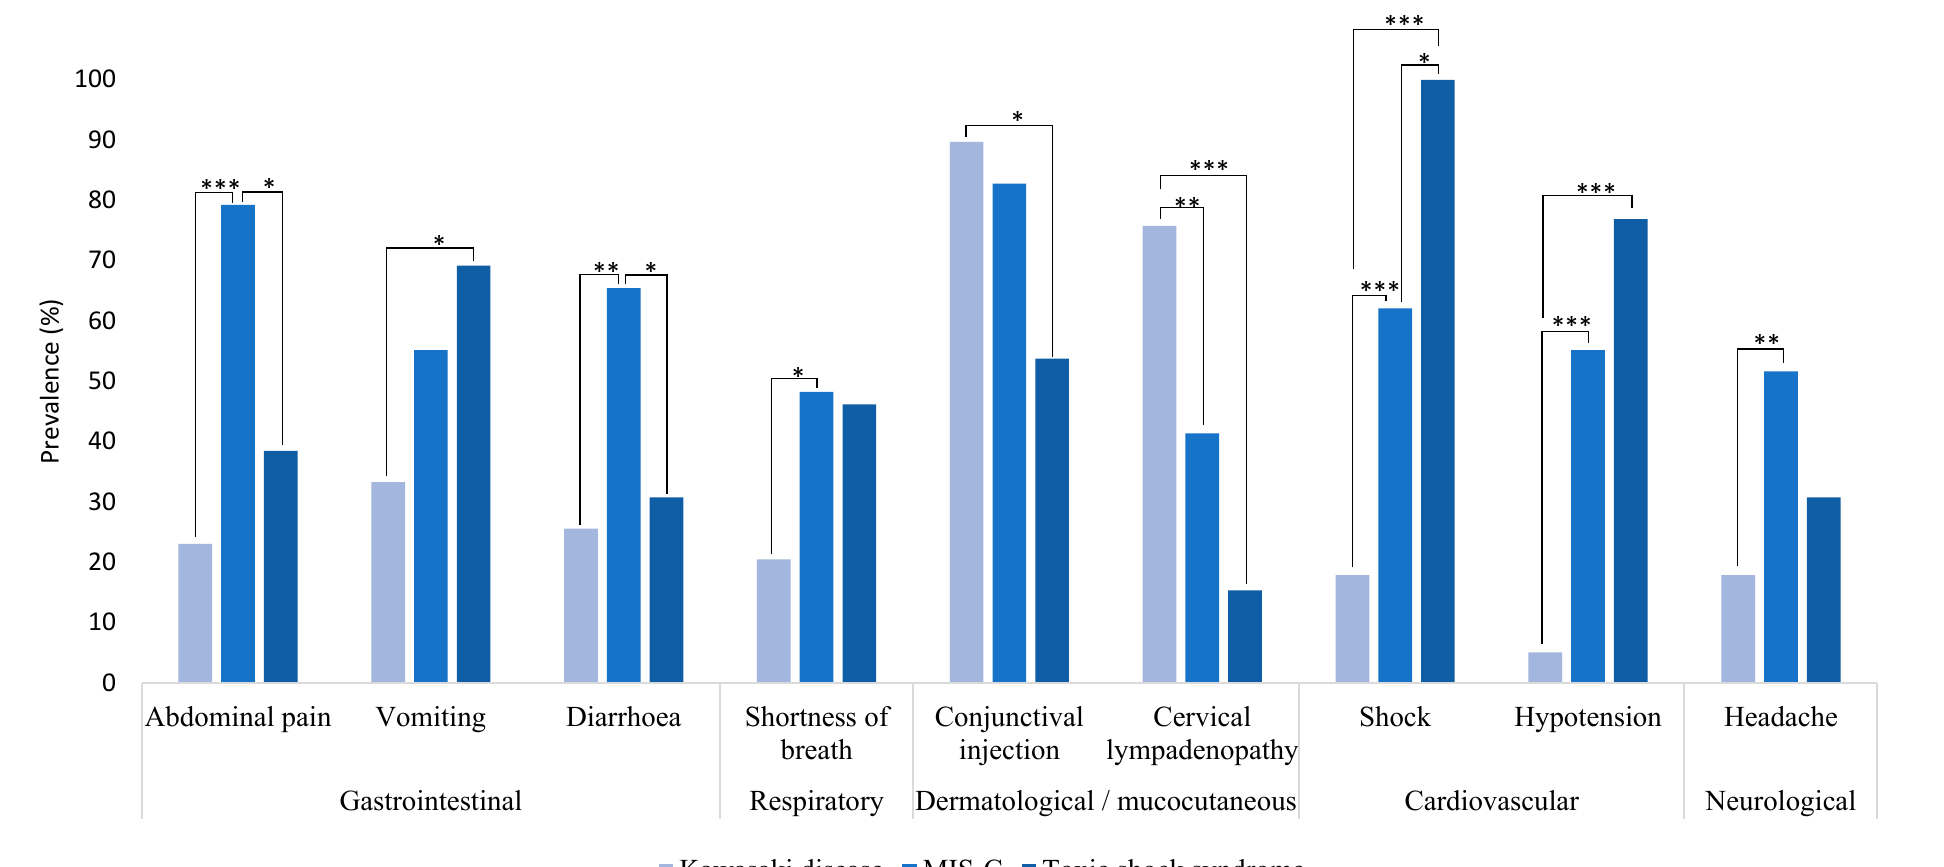
Figure 1. Clinical characteristics of patients with KD, MIS-C and TSS. * ( p < 0.05), ** ( p < 0.01), *** ( p < 0.001).